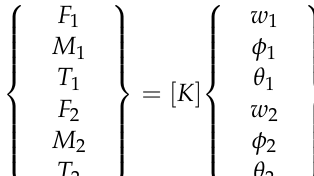
Table 1. Values of prescribed degrees of freedom (DOFs) in the 3D shell model. DOFs Case 1 Case 2 Case 3 Case 4 Case 5 Case 6 w 1 1 0 0 0 0 0 ϕ 1 0 1 0 0 0 0 θ 1 0 0 1 0 0 0 w 2 0 0 0 1 0 0 ϕ 2 0 0 0 0 1 0 θ 2 0 0 0 0 0 1 The above-prescribed displacements/rotations are applied to the nodes 1 and 2 located along the elastic axis, as shown in Figure 3, leaving the rest of the degrees of freedom free to move. Nevertheless, all the degrees of freedom of those nodes contained in the cross-sections located at nodes 1 and 2 of the shell model are coupled to reproduce rigid body motion. This is compatible with the structural behavior of the other standard Euler– Bernoulli beam elements when modelling the full wing geometry. the following standard relationship can be established: